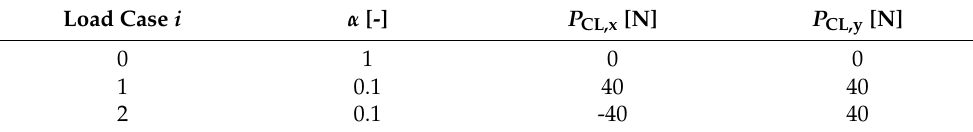
Table 5. Load cases for the path generation